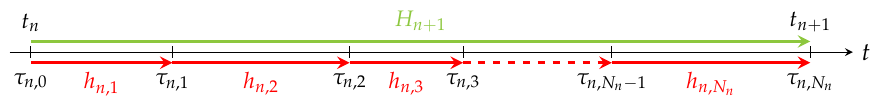
Figure 2. Depiction of macro and micro step sizes including corresponding notation.